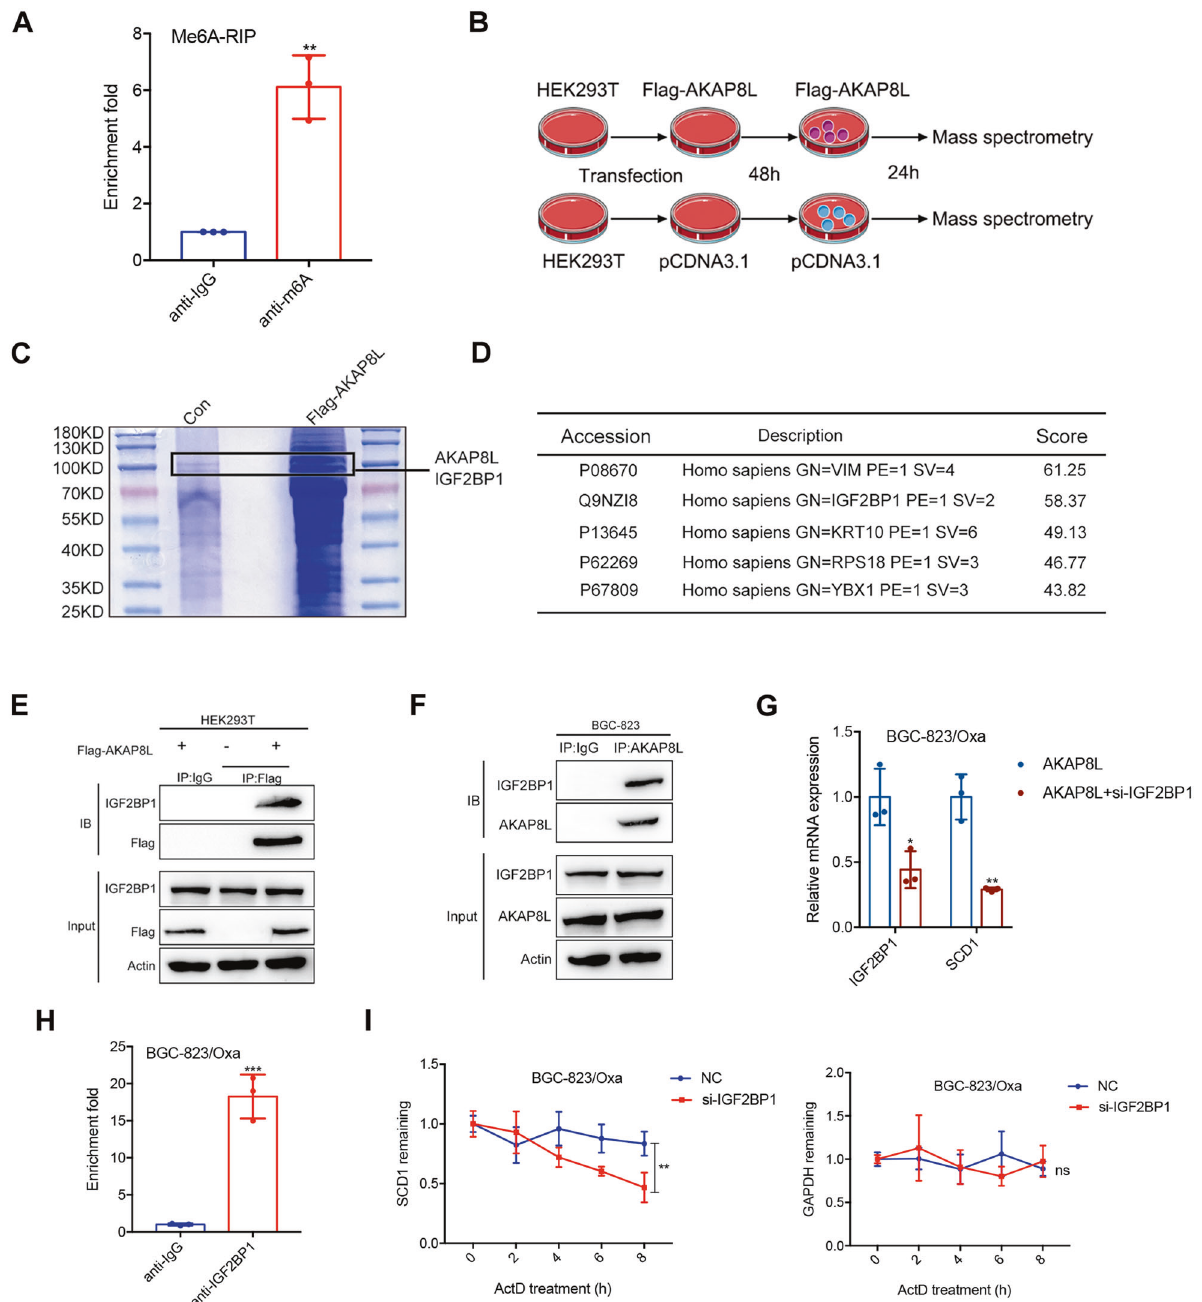
Fig. 6 AKAP8L stabilizes of SCD1 mRNA via IGF2BP1-dependent manner. A m6A RIP and qPCR were used to determine the percentage of SCD1 mRNA with m6A modi fi cation in Mettl3 overexpressing cells. Af fi nity mass spectrometry ( B – D ) and Co-IP assay ( E , F ) were performed to detect the interaction of proteins with AKAP8L. G AKAP8L overexpressing cells were transiently transfected IGF2BP1 siRNA. The mRNA level of SCD1 was measured by qPCR. H RIP were used to determine the percentage of SCD1 mRNA with IGF2BP1 in BGC-823/Oxa cells. I